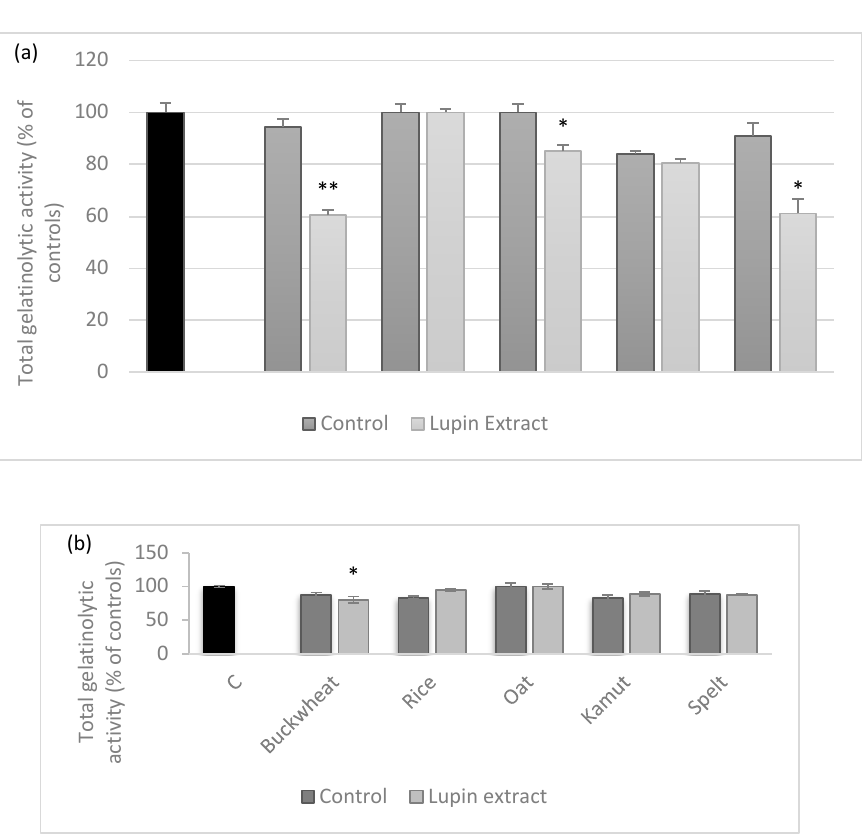
Figure 5. The effects of five different flours with and without LE on MMP-9 activity: ( a ) savoury cookies; ( b ) sweet cookies. The positive control (C) does not inhibit MMP-9, resulting in 100% proteolytic activity. All samples were added at the same volume (80 µL) and gelatinolytic activity was measured. Gelatinase activities are expressed as relative fluorescence as percentages of controls (C) and represent the means of three replicate experiments ( n = 3) ± SD. * p < 0.05 and ** p < 0.001 when compared to cookie controls.